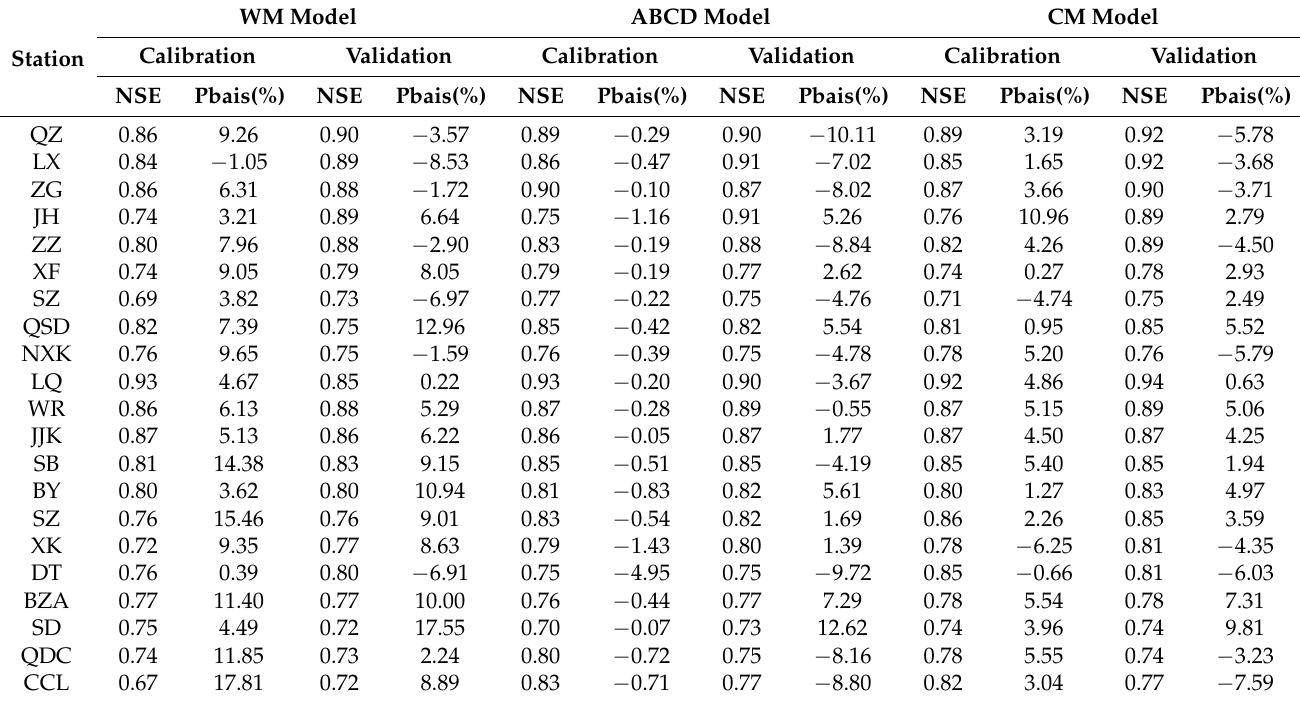
Table 4. Comparison of three models simulation results for each watershed using the APHRODITE